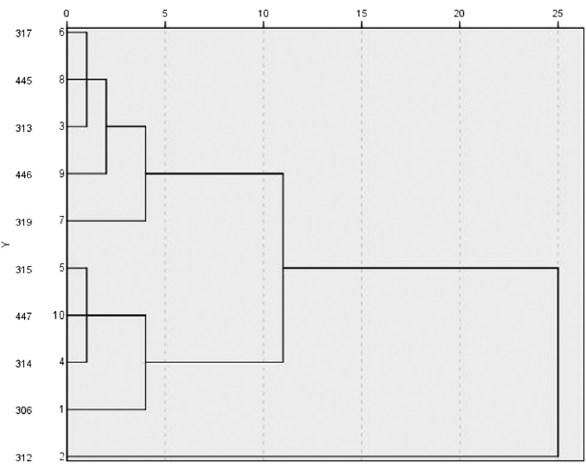
Figure 9: The cluster analysis of chlorogenic acid, echinacoside, and isorhamnetin - rutinoside in ten samples.